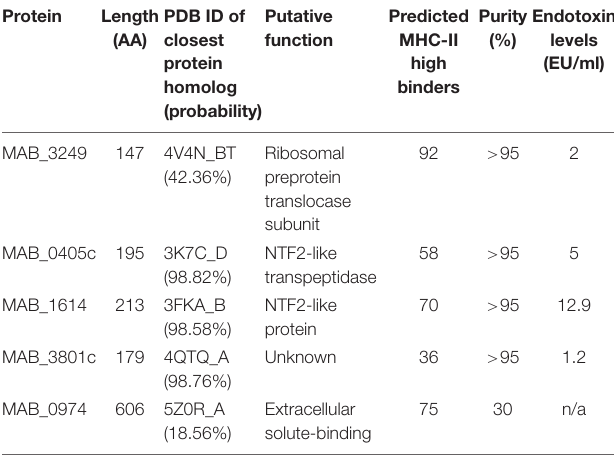
TABLE 2 | Characteristics of study